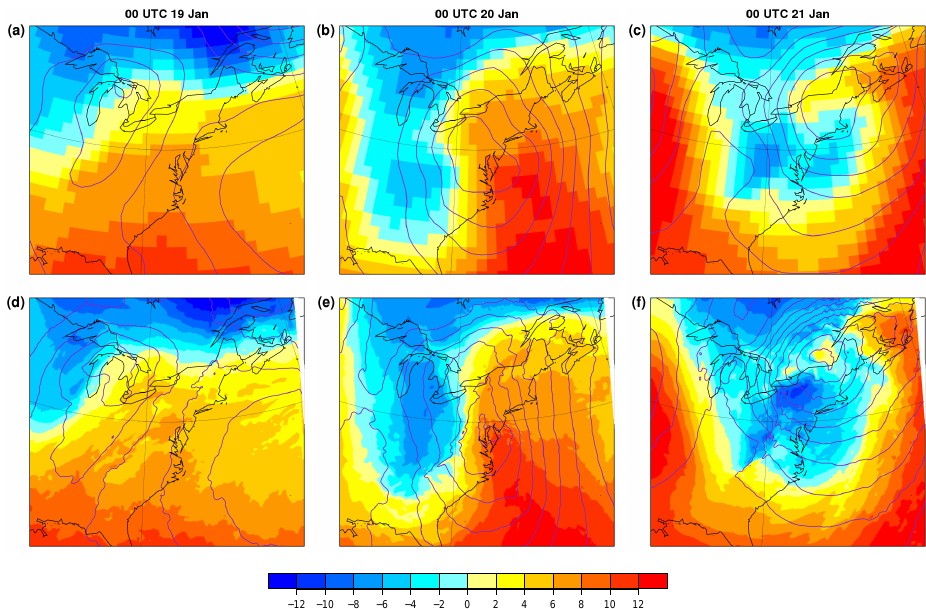
Fig. 2. Temperature on 850hPa (colours, in ◦ C) and sea level pressure (purple contours, contour interval 4hPa) at (a, d) 00:00UTC 19 January, (b, e) 00:00UTC 20 January and (c, f) 00:00UTC 21 January from ERA40 reanalyses (a–c) and the COSMO iso simulation (d–f)